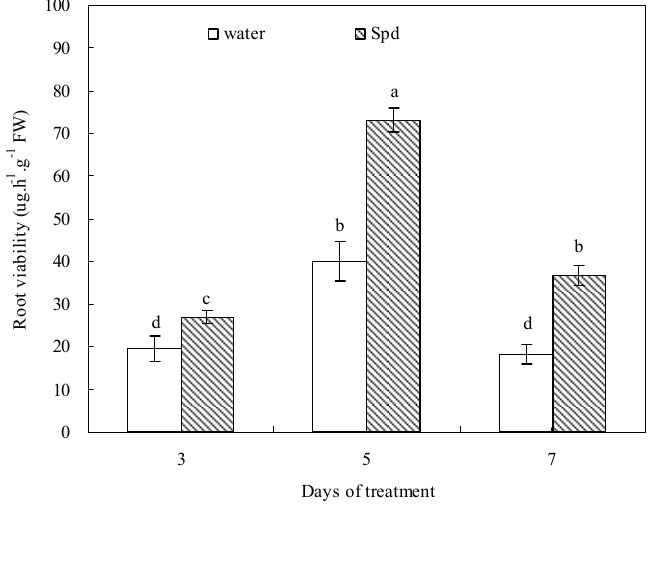
Figure 7. The effect of seed soaking with water or spermidine (Spd) on root viability in the process of seeds germination (7 days) under water stress induced by 15% PEG. Vertical bars indicate ± SE of mean ( n = 6). Different letters above columns indicate significant difference. LSD ( p ≤